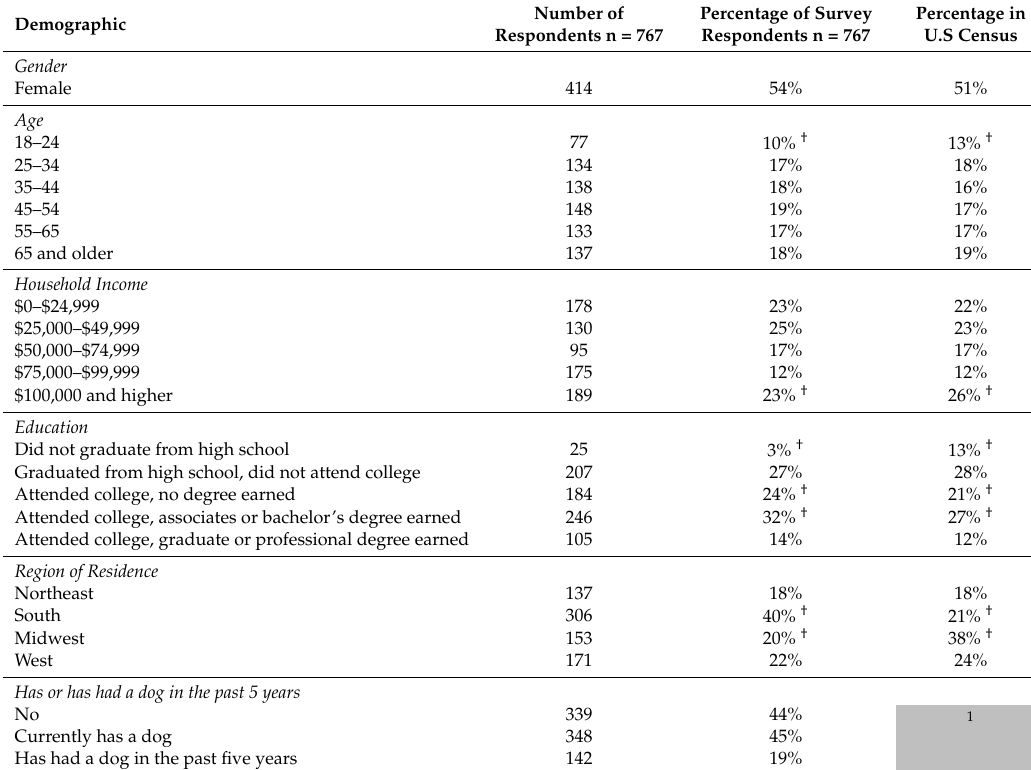
Table 1. Respondent demographics in percent compared to the U.S. Census using a proportion